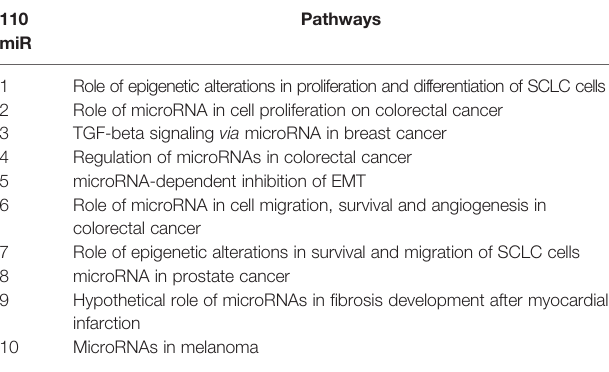
TABLE 1 | Top 10 pathway maps from 110 common miRNAs in the BC